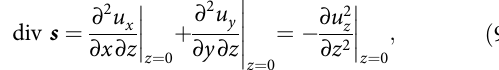
Figure 9 underlines this correlation by means of the power